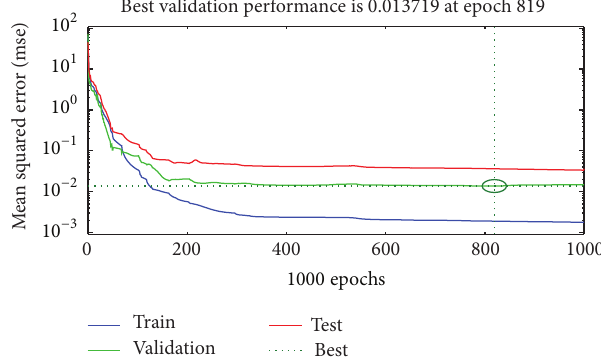
Figure 7: Performance graph of CFBP